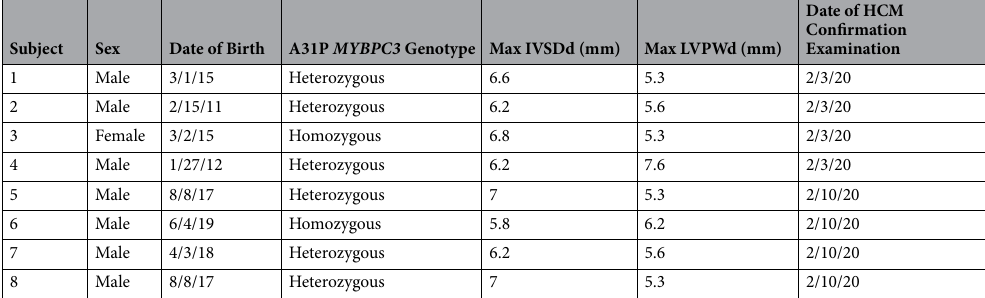
Table 1. Cat demographics and maximal left ventricular diastolic wall thickness. IVSDd intraventricular septum diameter (diastole), LVPWd left ventricular posterior wall (diastole), HCM hypertrophic